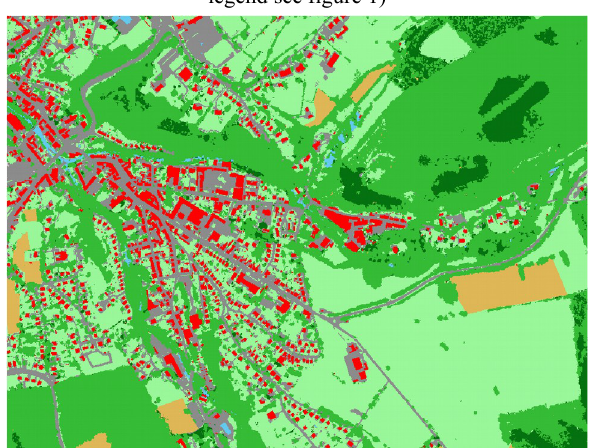
Figure 8: Rule-based fusion ((for legend see figure